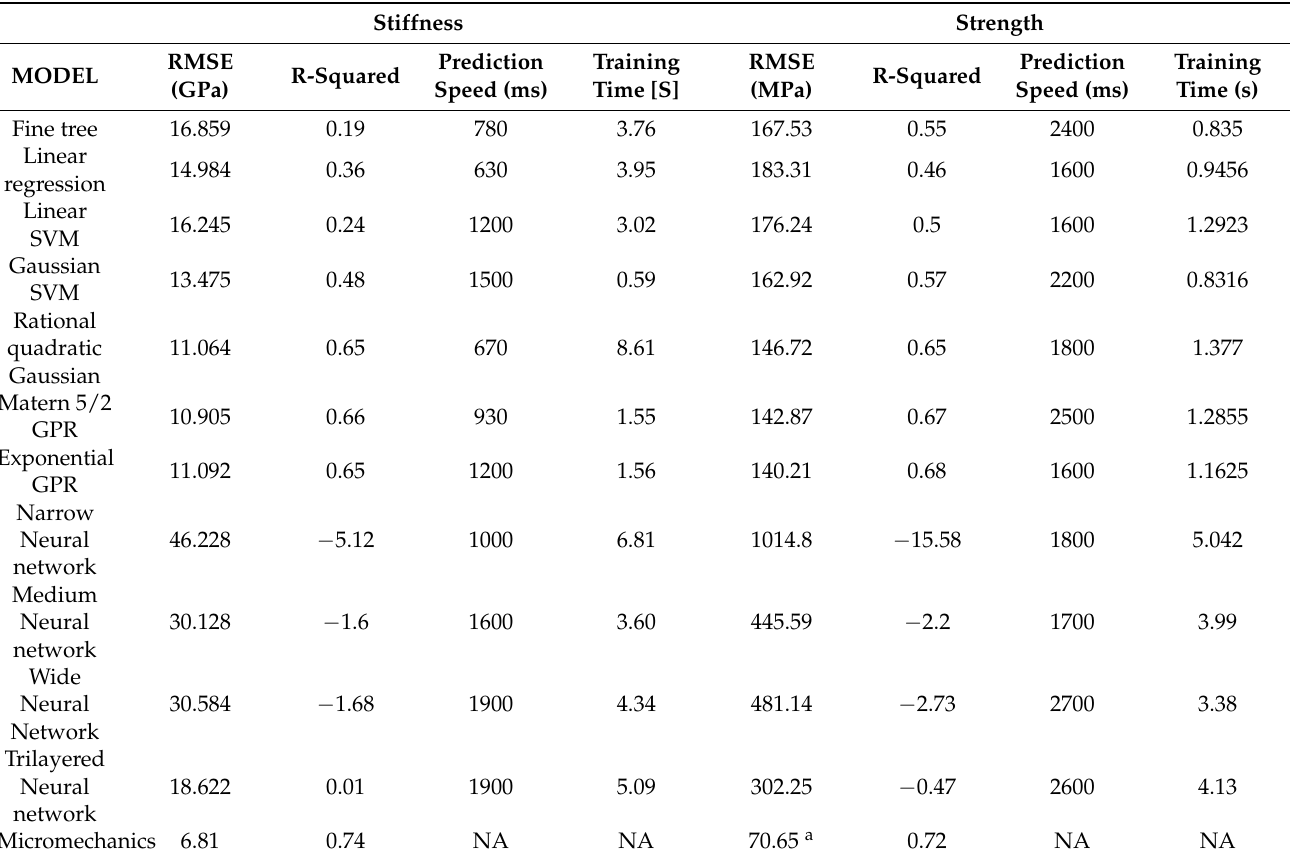
Table 7. Comparative table for the predicting model